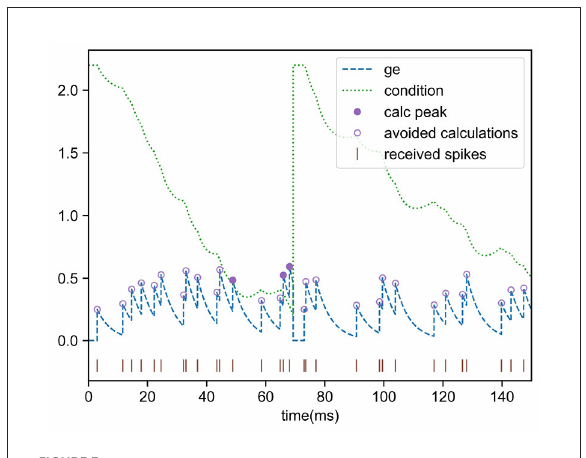
FIGURE3 Effect of conductance pre-filtering. The peak value needs to be calculated only when the updated conductance is greater than the